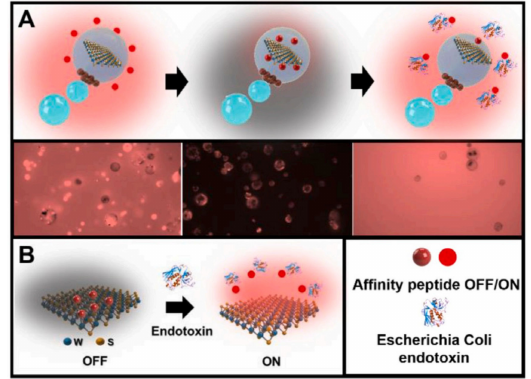
Figure 15. ( A ) Schematic of the Janus WS 2 -based micromotor strategy for Escherichia coli O111:B4 lipopolysaccharide (endotoxin) detection. From left to right: incubation with the specific affinity peptide (TMRholabeled); decrease in the fluorescence of the solution due to particular attachment to the WS 2 material encapsulated in the micromotor and fluorescent recovery in the solution due to competitive interaction and specific release in the presence of the target endotoxin. The bottom part shows time-lapse fluorescent images of each step. ( B ) The sensing principle is based on the specific decrease in the fluorescence of the solution due to the attachment of the labeled peptide via electrostatic and hydrophobic interactions with the 2D material and subsequent recovery due to the generation of an endotoxin-fluorescent marked peptide complex and specific detachment in a concentration-dependent manner. Reprinted with permission from ref. [188]. Copyright ©2020 Elsevier